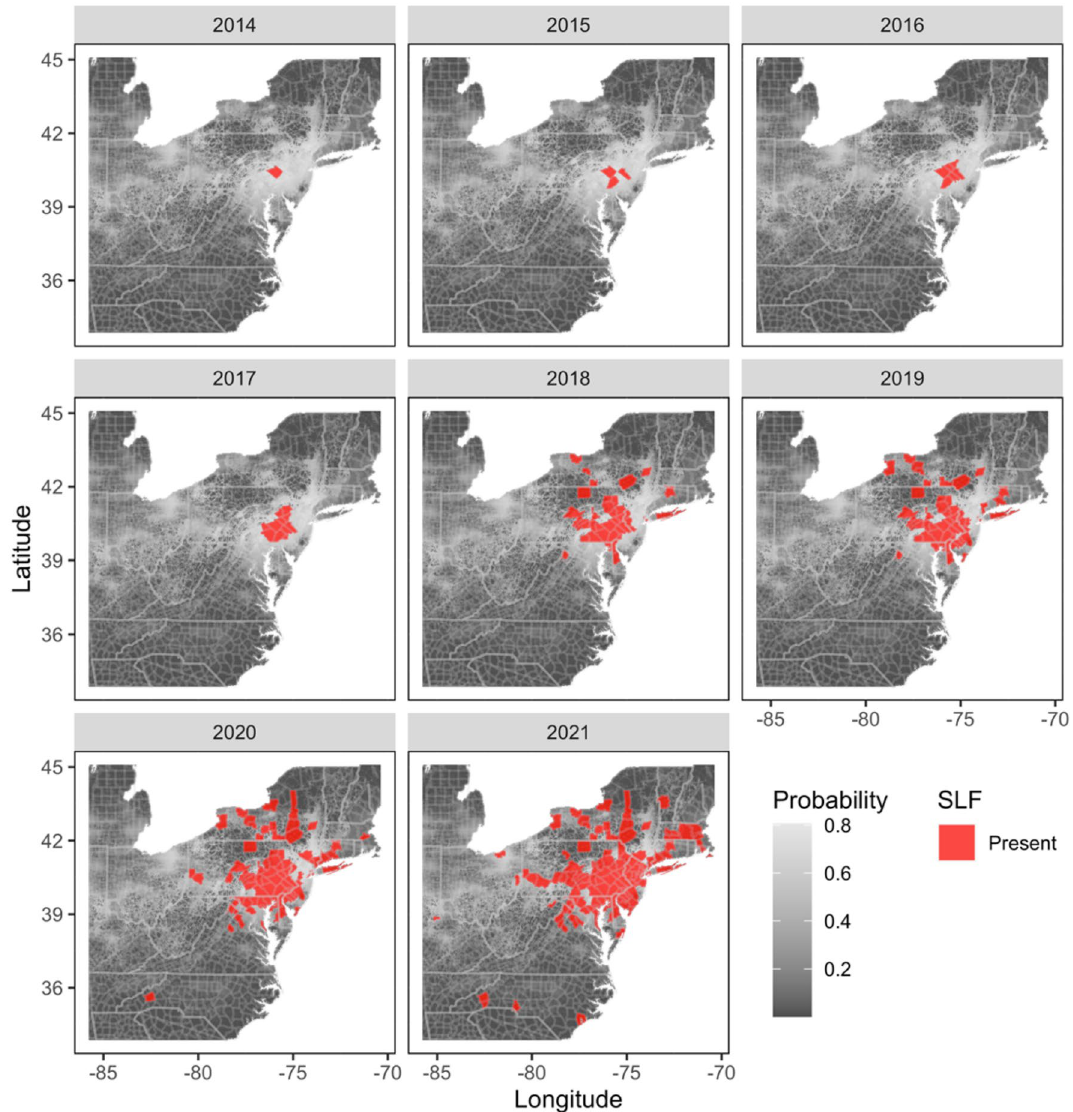
Figure 5. Maps showing observed county-level occurrence of spotted lanternfly ( Lycorma delicatula ) by year between 2014 and 2021 (red polygons) overlaid on Maxent model estimates of spotted lanternfly probability of occurrence. Probability of SLF occurrence ranges between low (< 0.01, dark gray) and high (> 0.8, light gray) values. The small multiple maps were produced using the ‘ggplot2’ (ver. 3.3.6; https:// cran.r- proje ct. org/ web/ packa ges/ ggplo t2/ index. html) and ‘ggmap’ (ver. 3.0.0.903; https:// cran.r- proje ct. org/ web/ packa ges/ ggmap/ index. html) packages in df = 4, P < 0.0001), but not between random or non-random movement types ( F = 1.55, df = 1, P = 0.21). We also found significant interactions between intrinsic growth rate and Year ( F = 2.47, df = 21, P < 0.001) and between the maximum number of human-mediated movements per year and Year ( F = 106.3, df = 28, P < 0.0001; Fig. 6A–D). Post-hoc tests indicated that Recall (mean ± SE) was greater in 2014 (1.0 ± 0.0) than in 2016 (0.92 ± 0.03), which was greater than both 2017 (0.88 ± 0.04) and 2015 (0.87 ± 0.04), followed by similar years 2018 (0.76 ± 0.05) and 2019 (0.75 ± 0.05), which were both greater than 2020 (0.71 ± 0.05) and 2021 (0.64 ± 0.05; Table 2 and Fig. 6A–D). Post hoc tests revealed differences in Recall among intrinsic growth rates, with r of 1.5 (0.83 ± 0.03) and 1 (0.82 ± 0.03) being similar, and r of 1.5 being greater than 0.25 (0.81 ± 0.03) which was greater than the intrinsic growth rate r of 0.5 (0.79 ± 0.03; Table 2 and Fig. 6A–D). For the number of maximum human-mediated move- ments per year, we found Recall which was similar among 3, 5, 7, and 10 maximum human-mediated movements per year (> 0.93 ± 0.01 in all cases) to be greater than 0 human-mediated movements (0.34 ± 0.04; Table 2 and Fig. 6A–D). For the F 1 model performance metric, we found differences in main effects among years ( F = 1346.6, df = 7, P < 0.0001), the maximum number of human-mediated movements per year ( F = 11.05, df = 4, P < 0.0001), and between random (0.32 ± 0.02) and non-random (0.31 ± 0.02) movement ( F = 1.41, df = 1, P < 0.001), but not among